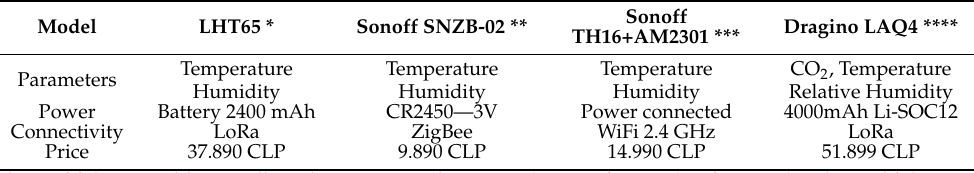
Table A3. Characteristics of devices with ambient sensors.